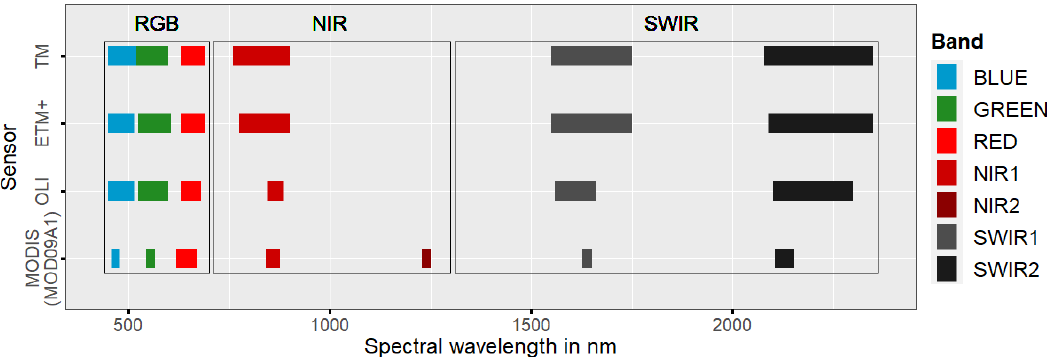
Figure A2. Spectral wavelengths covered by different sensors within the visible RGB, NIR and SWIR regions. Bands of the sensors TM [66], ETM+ [67], OLI [67] and the MODIS product MOD09A1 [56] are